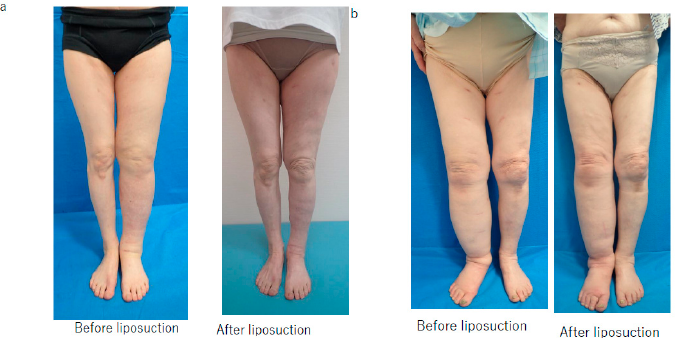
Figure 1. Representative examples of successful and unsuccessful outcomes after liposuction ac- cording to type of compression strategy. ( a ) The patient was a 71-year-old woman with secondary lymphedema in the left lower limb in whom there was insufficient improvement after lymphati- covenous anastomosis surgery. After removal of 2000 mL of fat by liposuction and wearing both a compression stocking and bandage for 6 months, her lower extremity lymphedema index improved by 20.4, which was considered a successful outcome. ( b ) The patient was a 78-year-old woman with secondary lymphedema in the right lower limb that did not improve adequately after lymphati- covenous anastomosis surgery. After removal of 1800 mL of fat by liposuction and wearing a band- age alone for 6 months, her lower extremity lymphedema index improved by only 12.3, which was considered an unsuccessful result.